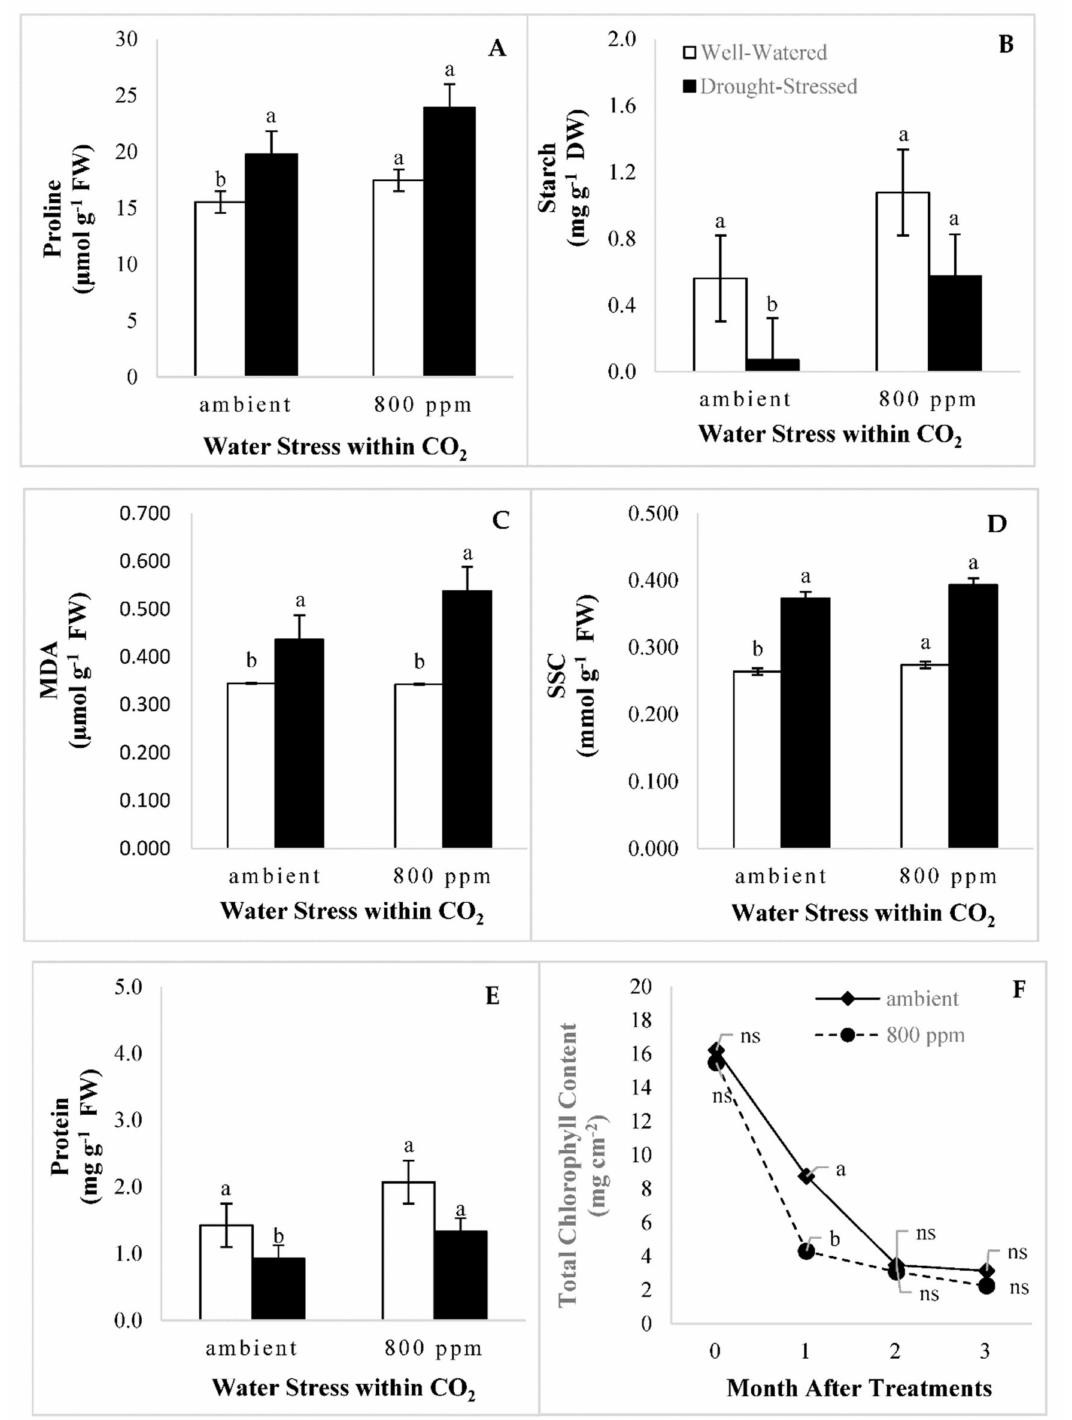
Figure 3. Effect of water stress within CO 2 levels with brassinolide application on Ficus sp. ( A ) proline content at second month after treatment (MAT), ( B ) starch at third MAT, ( C ) MDA at third MAT, ( D ) SSC at third MAT, and ( E ) protein content at third MAT, and ( F ) T − Chl as the main effect of water stress. Bars and curves (solid line is well − watered and dashed line is drought stressed) represent means ± SD. Bars with different letters were significantly different by Fisher’s LSD at p <